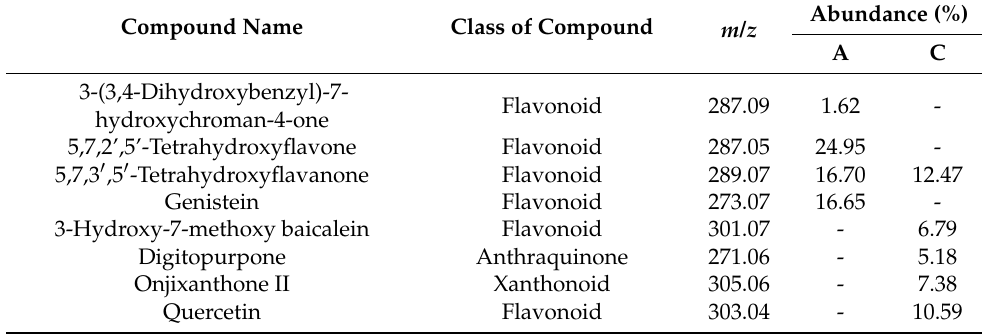
Table 3. Compounds identified in A. crassicarpa and A. auriculiformis extracts by